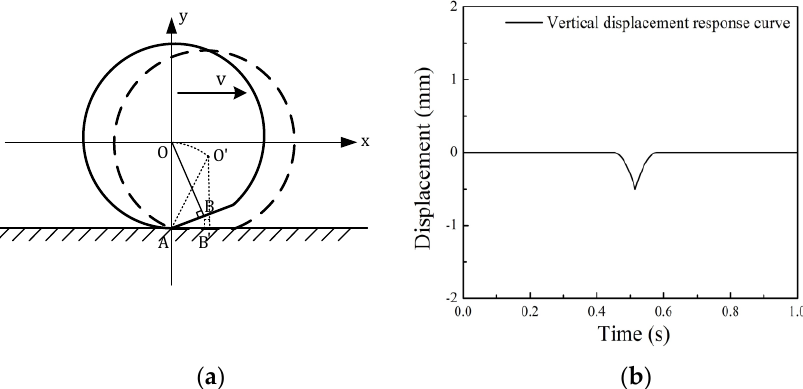
Figure 1. The vertical motion of a wheel flat: ( a ) The geometry of a wheel flat; ( b ) The vertical displacement response curve of point O .